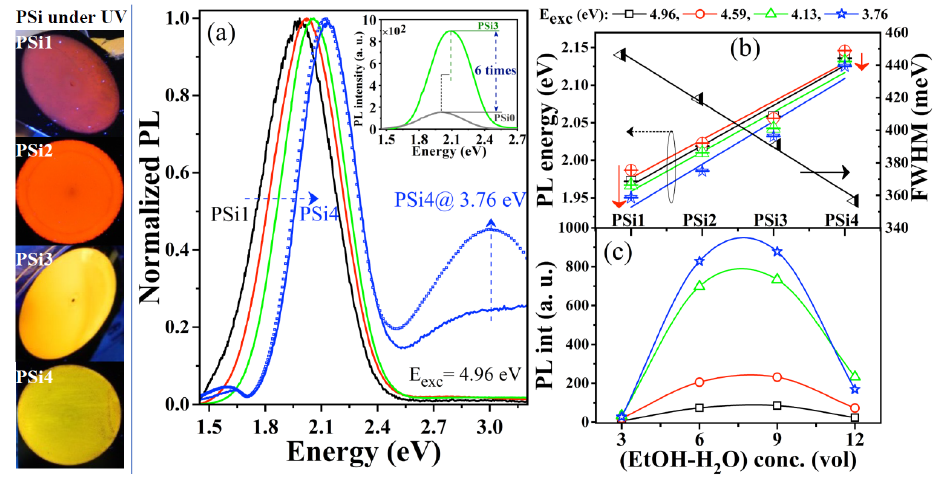
Figure 1. Images of PSi films under UV excitation (left): ( a ) normalized PL spectra; ( b ) PL peak energy and FWHM; and ( c ) PL intensity for different energy excitations of PSi films and as function of the EtOH-H 2 O concentration in the HF:HNO 3 :(EtOH-H 2 O) electrolyte. Labels PSi1-PSi4 are also indicated for clarity in their respective EtOH-H 2 O concentrations. Inset in ( a ) shows a comparison between PSi0 and PSi3 films. Lines in ( c ) are for eye-guide.